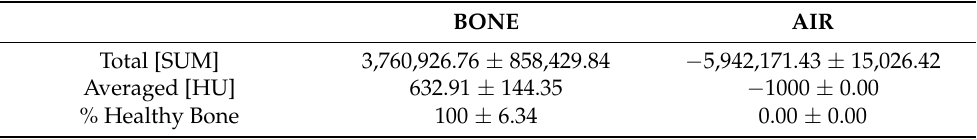
Table 2. Radiological results after 3 weeks of bone and air. Both groups have been analysed for reference use but were not compared with the rest of the study